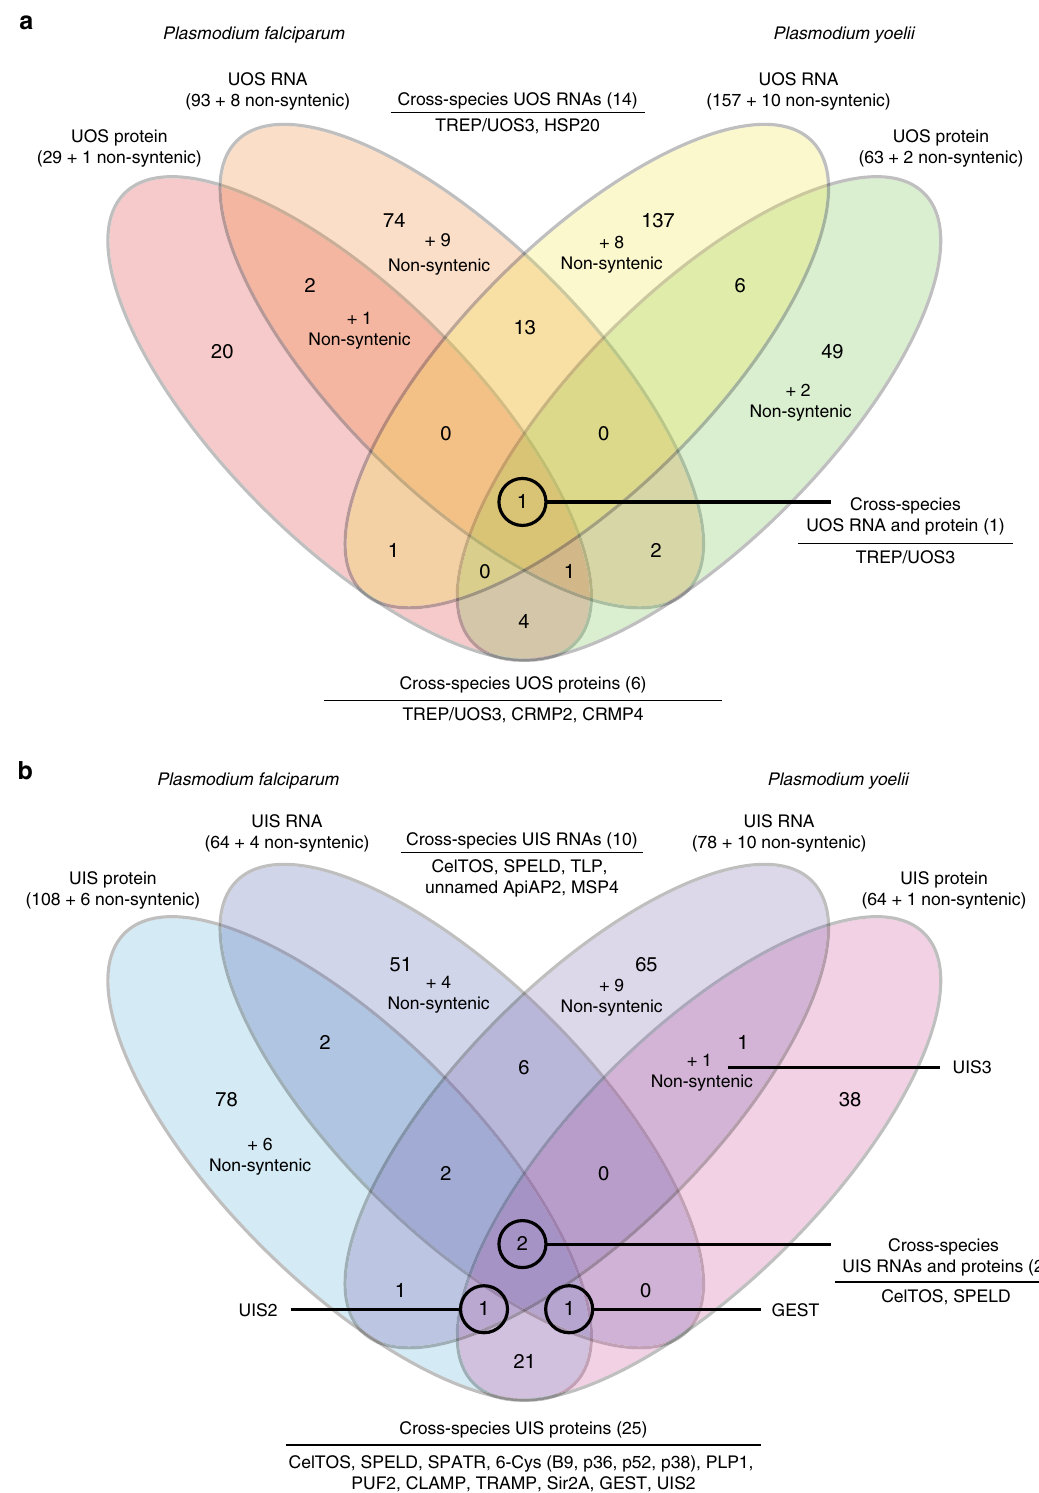
Fig. 3 Comparisons of UOS and UIS Gene Products. RNAs or proteins in the top decile of abundance that were also at least fi vefold (mRNA) or sixfold (protein) more abundant in either oocyst sporozoites or salivary gland sporozoites were denoted as UOS or UIS gene products, respectively. Comparisons across molecule types and species for a UOS and b UIS identify many gene products that are critical/essential to sporozoite development and/or transmission. Gene products that are similarly regulated across species, transcriptional levels, and/or translational levels are